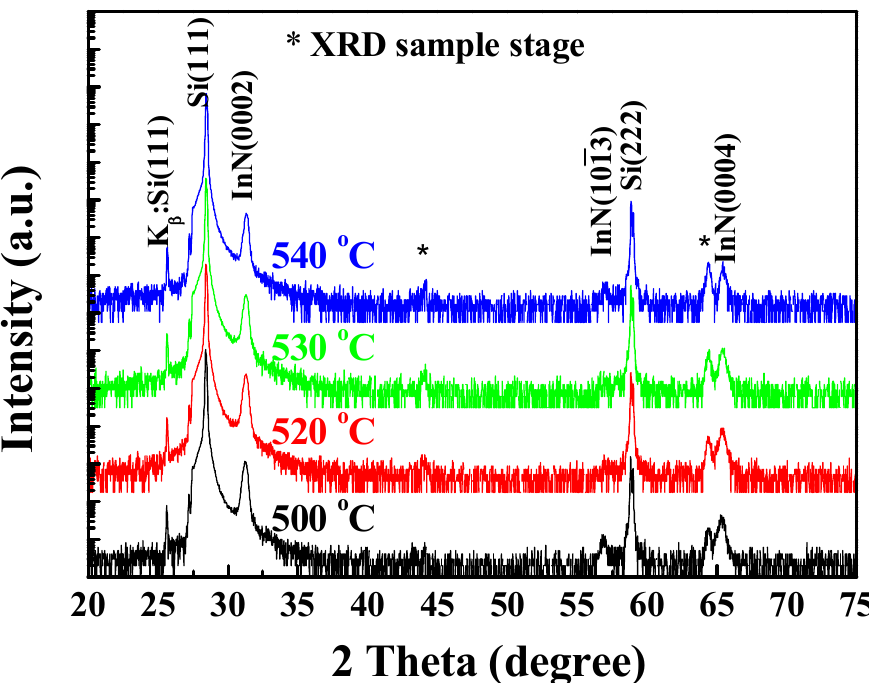
Figure 1. X-ray di ff raction (XRD) θ –2 θ di ff raction patterns of InN grown on nitrided Si(111) substrates Figure 1. X-ray diffraction (XRD) θ –2 θ diffraction patterns of InN grown on nitrided Si(111) substrates at di ff erent temperatures from 500 ◦ C to 540 ◦ at different temperatures from 500 °C to 540 °C.